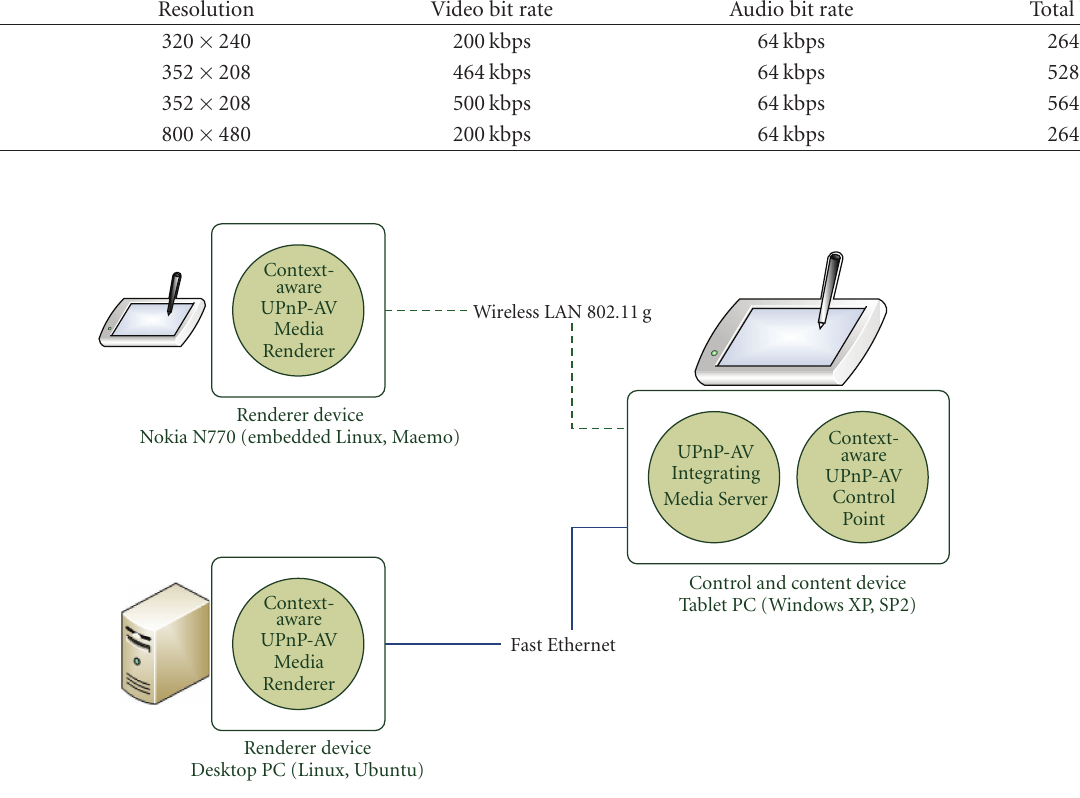
Figure 7: UPnP-AV Media Renderer performance test